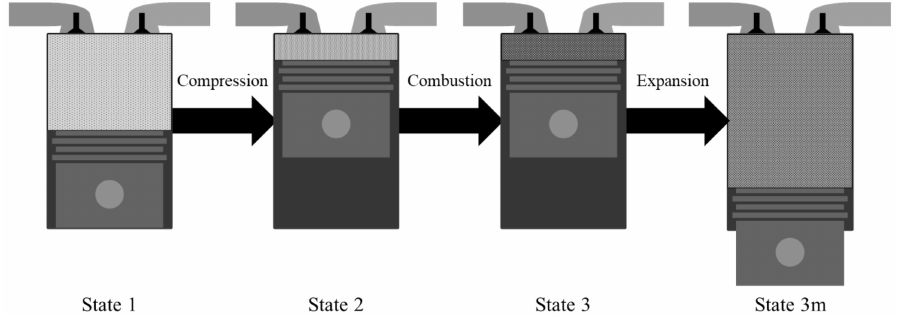
Figure 1. System